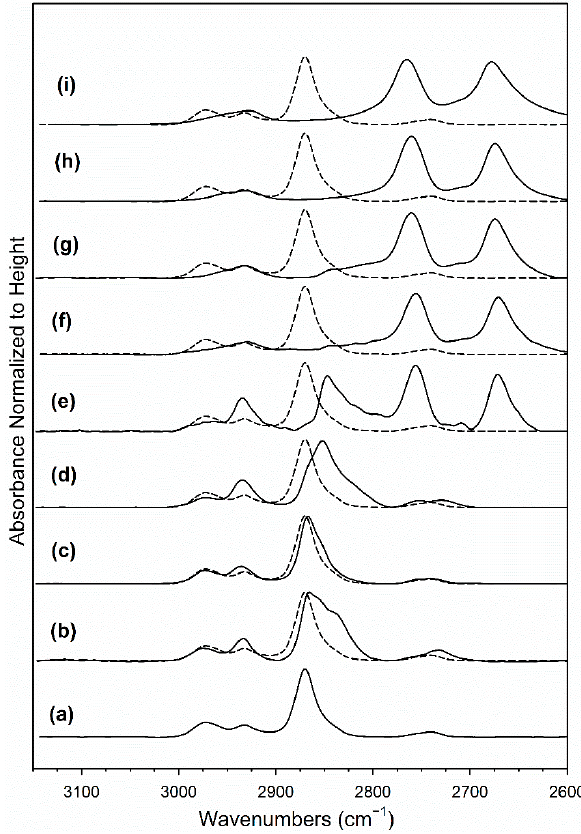
Figure 12. Absorbance of the formate ν (CH) band region normalized to height of band on 2%Pt/ZrO 2 , including ( a and dashed line spectra) 2%Pt/ZrO 2 , and the same catalyst doped with ( b ) 0.55%Rb, ( c ) 0.93%Rb, ( d ) 1.86%Rb, ( e ) 2.79%Rb, ( f ) 3.72%Rb, ( g ) 4.65%Rb, ( h ) 5.58%Rb, and ( i ) 9.29%Rb.